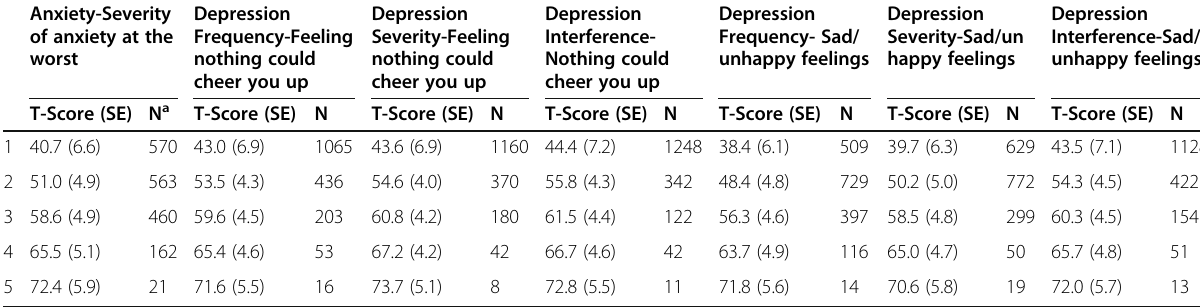
Table 5 Cross-walk Table for the PRO-CTCAE items for anxiety and depression Anxiety-Severity of anxiety at the